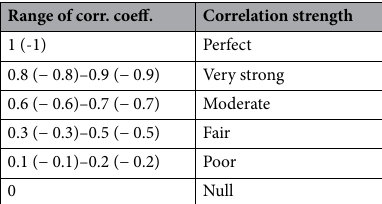
Table 5. Interpretation of Spearman’s correlation coefficients as used in the work